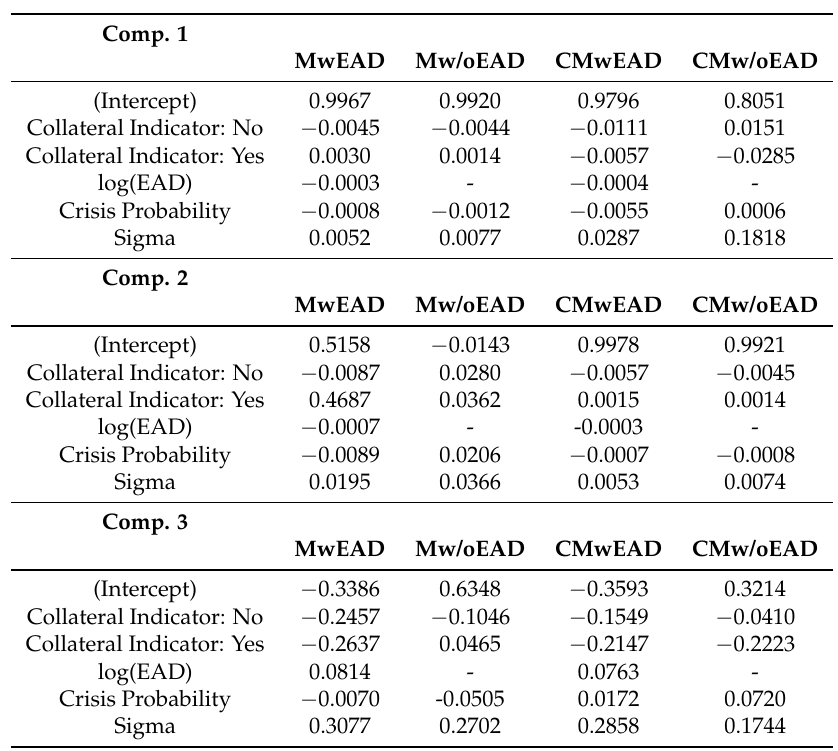
Table 4. Summary of the estimated mixture regression models MwEAD (inclusion of the attribute EAD), Mw/oEAD (exclusion of the attribute EAD), and the estimated concomitant variable models CMwEAD (inclusion of the attribute EAD) and CMw/oEAD (exclusion of the attribute